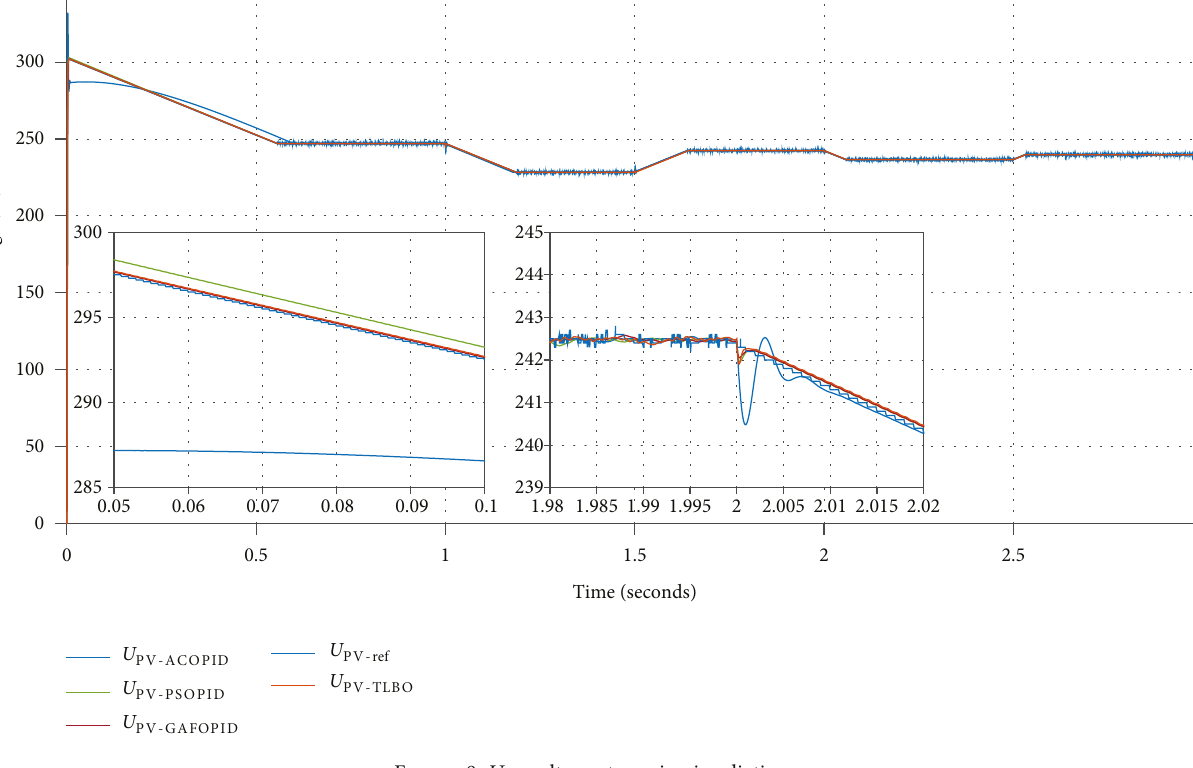
Figure 8: U pv voltage at varying irradiation.